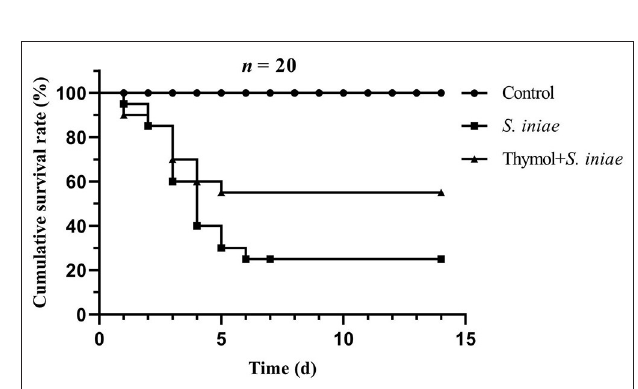
FIGURE 11 | The cumulative survival rate of channel catfish in each group after 2 weeks post-infection.